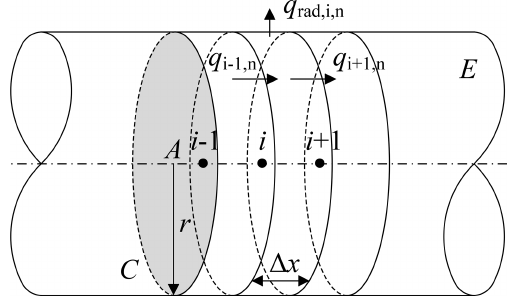
Figure 2. Discretisation of the cylindrical rod with disc shaped con- trol volumes.